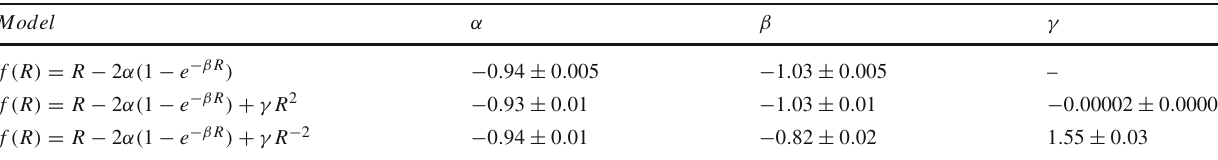
Table 5 Forms of f ( R ) theory and constraints obtained for the model parameters when H 0 = 67 . 40 ± 0 . 5 km s − 1 Mpc − 1 has been merged to the expansion rate data used in the GP. The constraints correspond to the models given by Eqs. (22), (24) and (26),